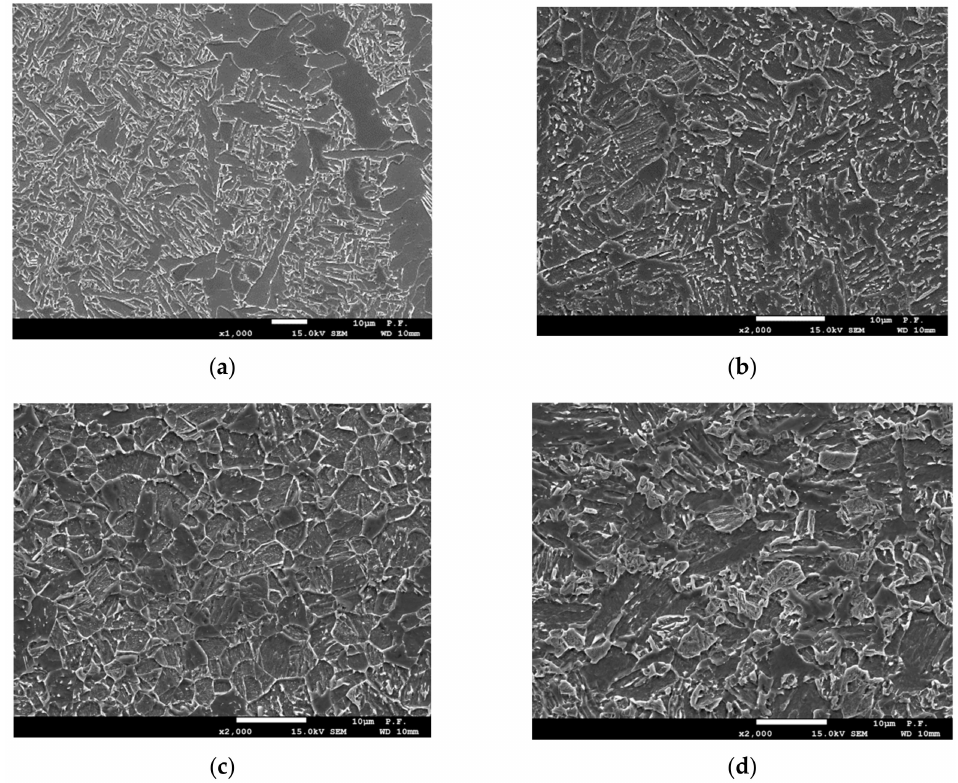
Figure 4. Microstructure in joint welded according to Q 1: ( a ) WM; ( b ) HAZ1; ( c ) HAZ2; ( d )